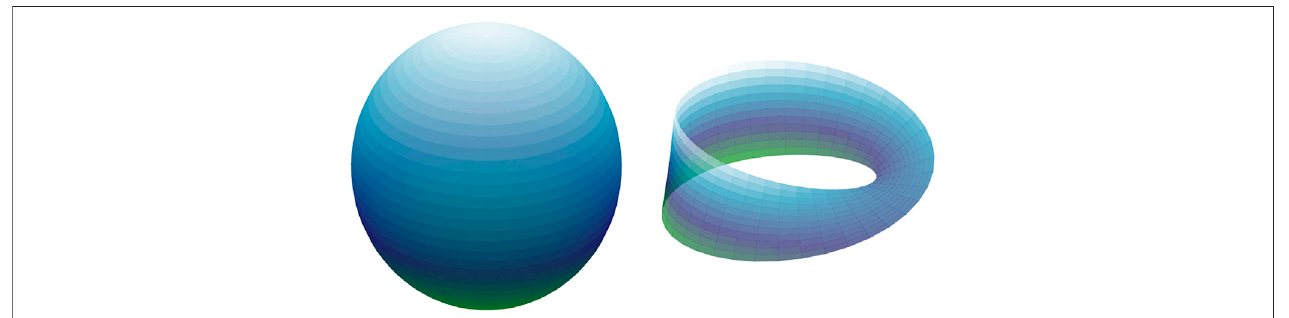
FIGURE 1 | Left: The 2-dimensional sphere S 2 ⊂ R 3 , right: the Möbius band M .